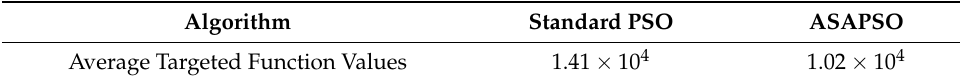
Table 5. Comparison of targeted function values from two